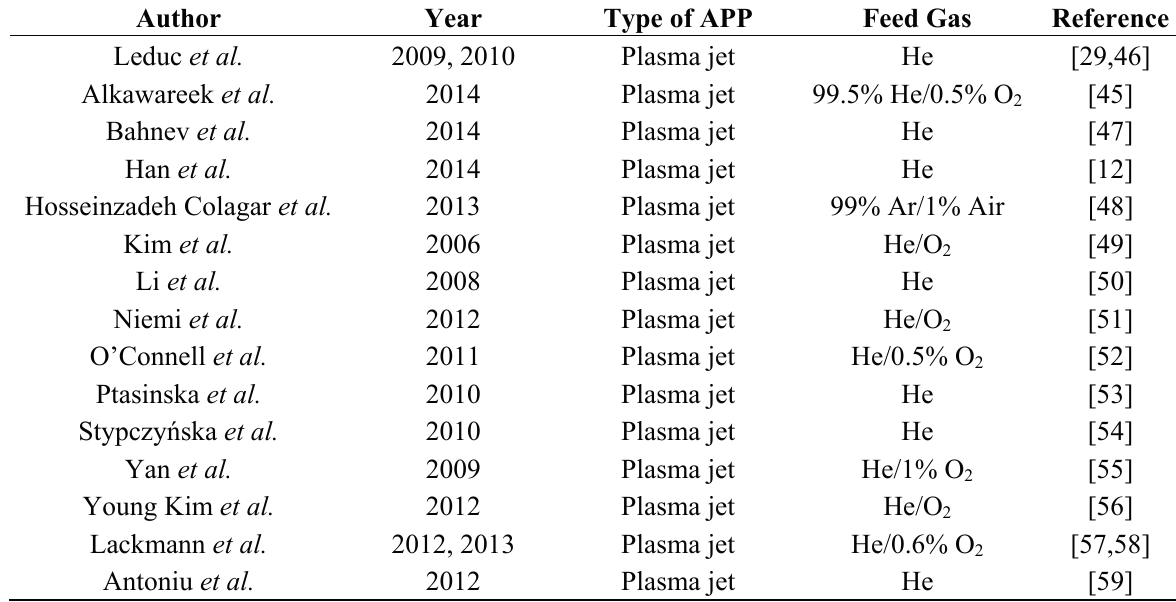
Table 1. Summary of various types of APPs and feed gases used to characterize the effect of APPs on isolated and cellular